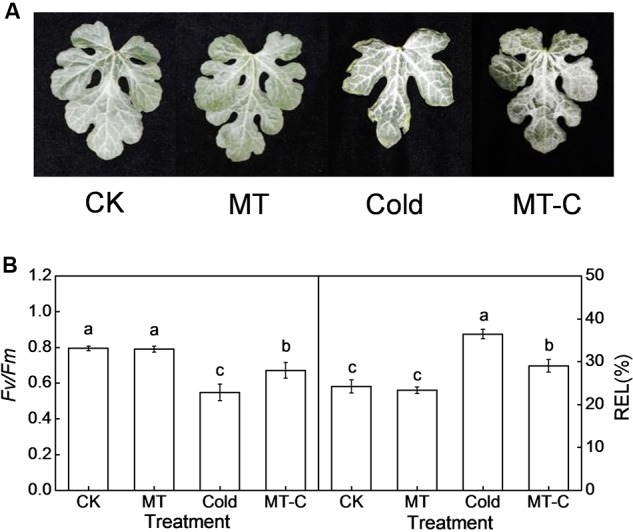
Changes in (A) the leaf phenotypes, (B) the maximum photochemical efficiency of PSII (Fv/Fm) and relative electrolyte leakage (REL) as influenced by melatonin or/and cold stress. Leaves of watermelon (Citrullus lanatus L.) seedlings at the four-leaf stage were pretreated with 150 μM melatonin (MT) for 3 days. Then, they were exposed to cold stress (i.e., 4°C) for 36 h. Data of Fv/Fm are the means of six replicates (±SD). Data of REL are the means of four replicates (±SD). Means denoted by the same letter did not significantly differ at P < 0.05 according to Tukey’s test. CK, Control; MT, Melatonin; Cold; MT-C, Melatonin+Cold.